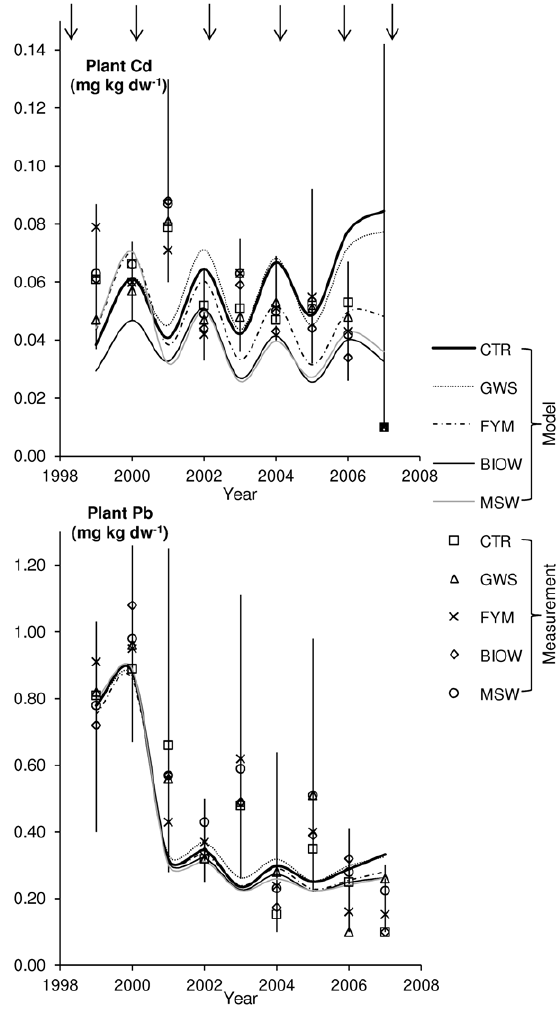
Figure 3. Comparison of predicted and measured concentra- tions in plants (mg kg dw 2 1 ) for the five treatments. October 1999 to July 2007. Model predictions are connected by lines for clearer comparison to measured values. Vertical lines denote the range of measured values and symbols the medians of the four replicates (values below QL were set equal to K QL (note that QLs from 1999–2005 were applied for all years). Top arrows recall the time of amendment application.